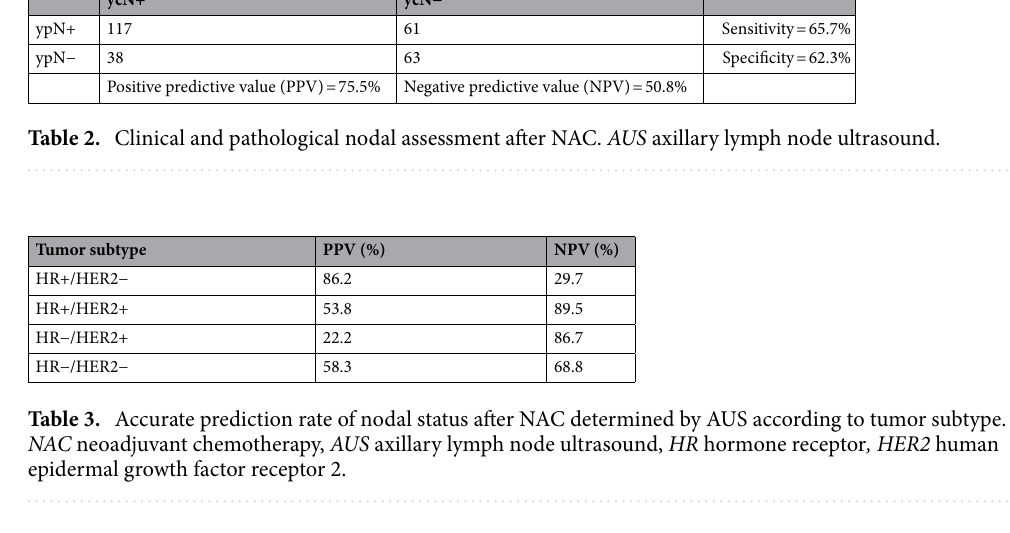
ycN+ ycN− ypN+ 117 61 Sensitivity = 65.7% ypN− 38 63 Specificity = 62.3%